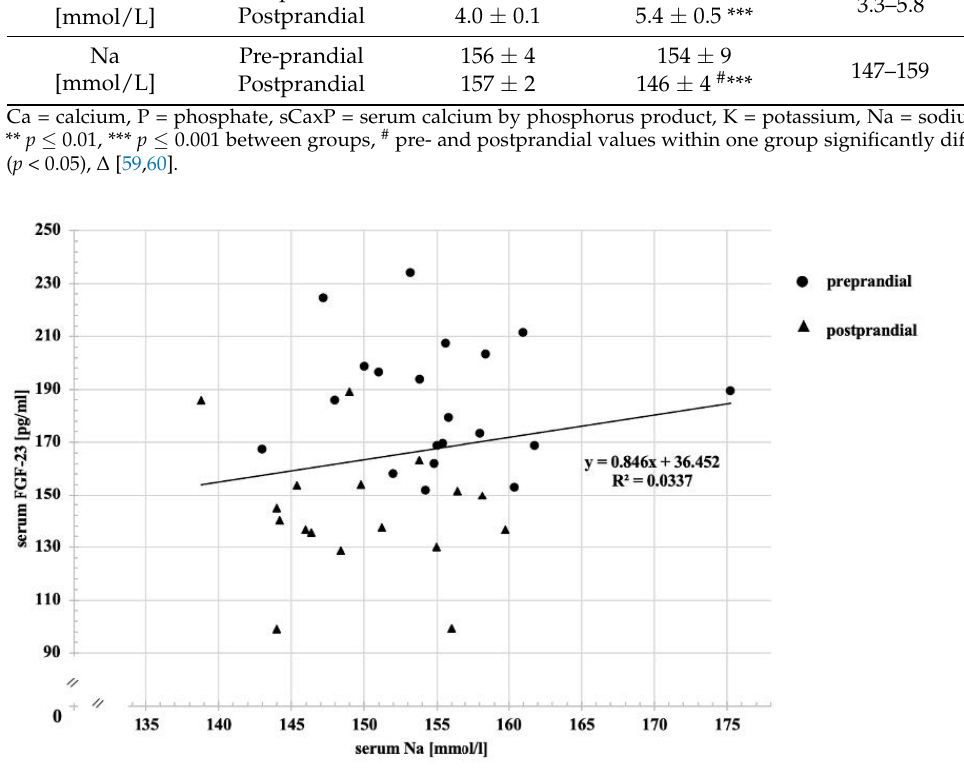
Figure 2. Correlation between serum Na and serum FGF23. Table 3. Concentrations of serum parameters after 28 days of high NaCl or control feeding in cats (mean ± standard deviation).